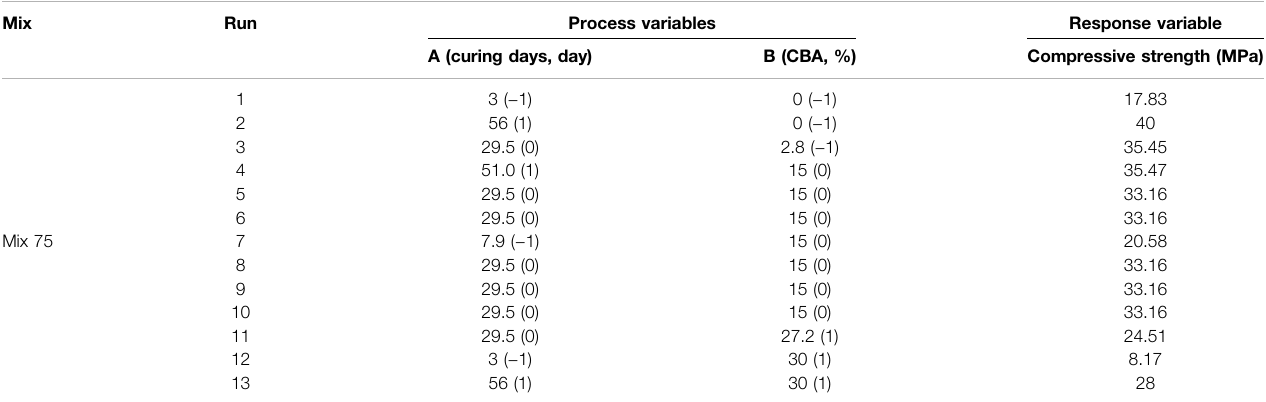
TABLE 7 | Design layout in RSM and ANOVA for Mix 75.